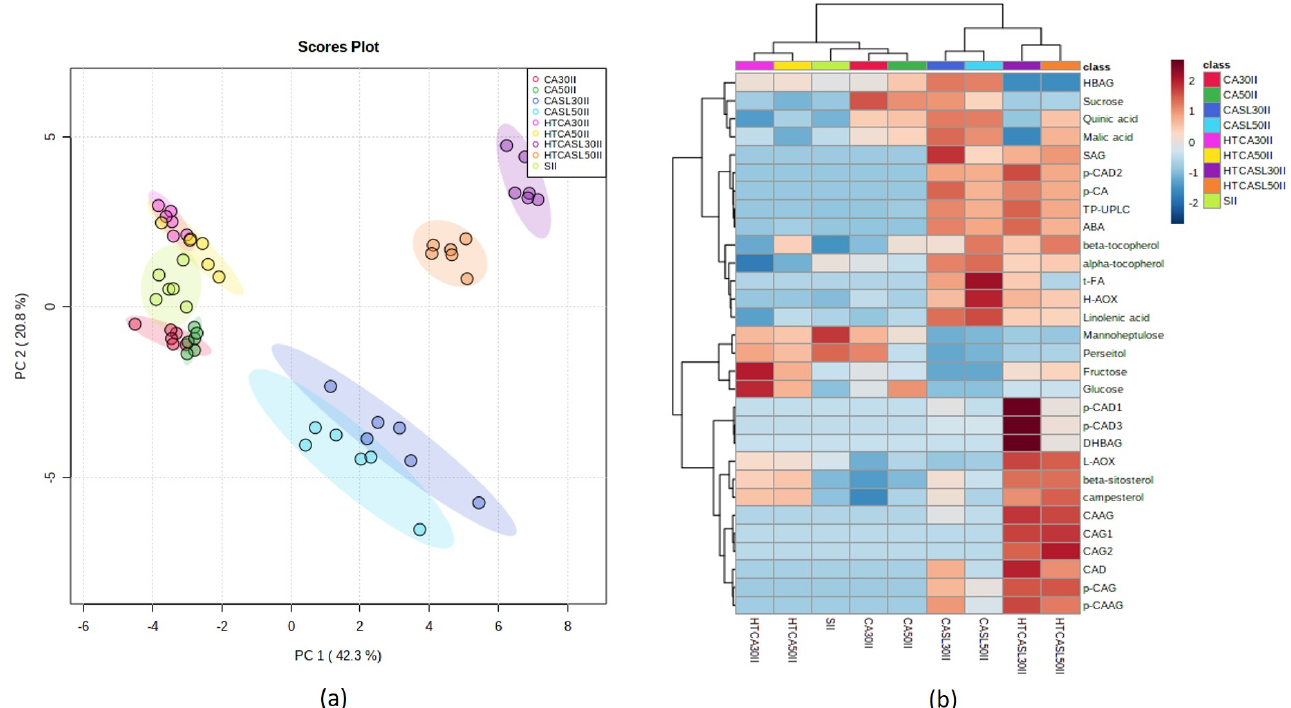
Figure 3. Principal component analysis of the middle harvest dataset. ( a ) Score plot and ( b ) heat map based on hierarchical cluster analysis based on Euclidean distance and Ward algorithm with the 25 significant metabolites revealed by ANOVA followed by the Tukey test ( p < 0.05). Samples correspond to different treatments, storage times, and corresponding edible ripeness stages. Samples corresponding to the different conditions are on the horizontal axis. SII = Initial day middle harvest; CA30II and CA50II = controlled atmosphere for 30 and 50 days middle harvest; CASL30II and CASL50II = controlled atmosphere for 30 and 50 days middle harvest after shelf-life period; HTCA30II and HTCA50II = hydrothermal treatment for 30 and 50 days middle harvest; HTCASL30II and HTCASL50II = hydrothermal treatment for 30 and 50 days middle harvest after shelf-life period. The average of the 6 replicates is displayed. DM = dry matter, ABA = abscisic acid, H-AOX = hydrophilic antioxidant activity, L-AOX = lipophilic antioxidant activity, DHBAG = dihydroxybenzoic acid glycoside, SAG = syringic acid glycoside, CAG1 = caffeic acid glycoside 1, CAG2 = caffeic acid glycoside 2, HBAG = hydroxybenzoic acid glycoside, p -CAG = p-coumaric acid glycoside, CAD = caffeic acid derivative, p -CAD1 = p -coumaric acid derivative, CAAG = caffeic acid acetilglycoside, p -CA = p -coumaric acid, p -CAAG = p -coumaric acid acetylglycoside, p -CAD2 = p -coumaric acid derivative, t -FA = trans-ferulic acid, p -CAD3 = p -coumaric acid derivative.